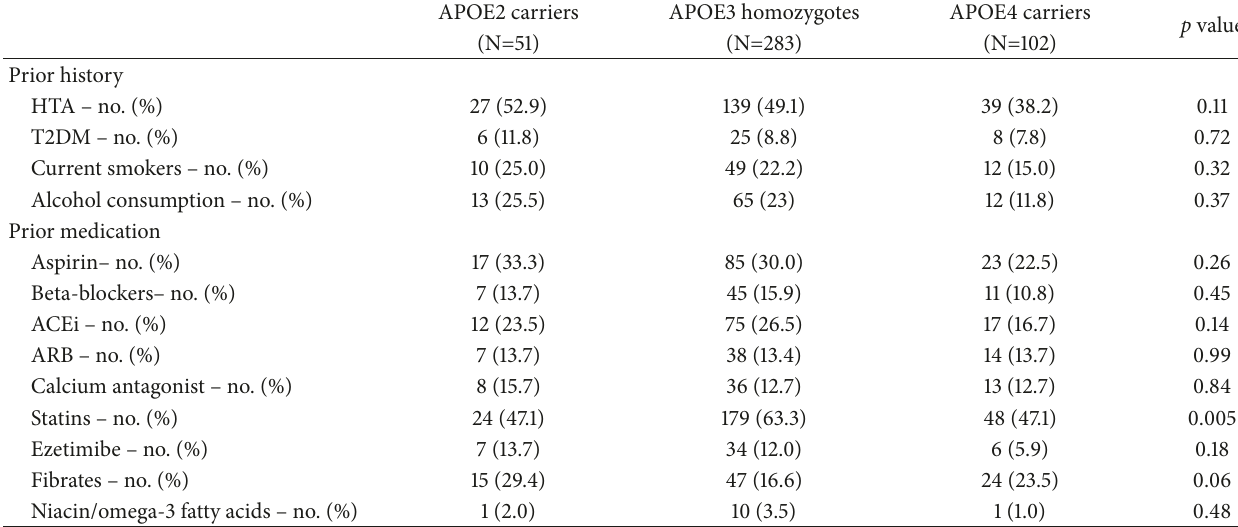
Table 3: Baseline prior history and medication of the 436 patients with different APOE